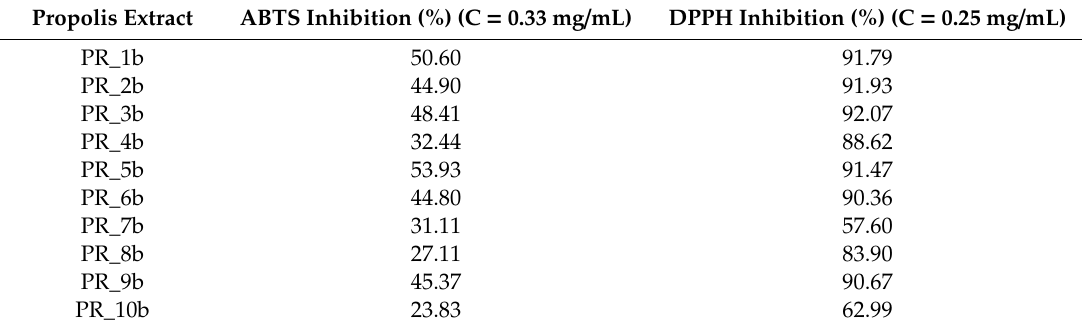
Table 4. ABTS and DPPH free radical activity of the ten methanolic propolis extracts examined in the present study.